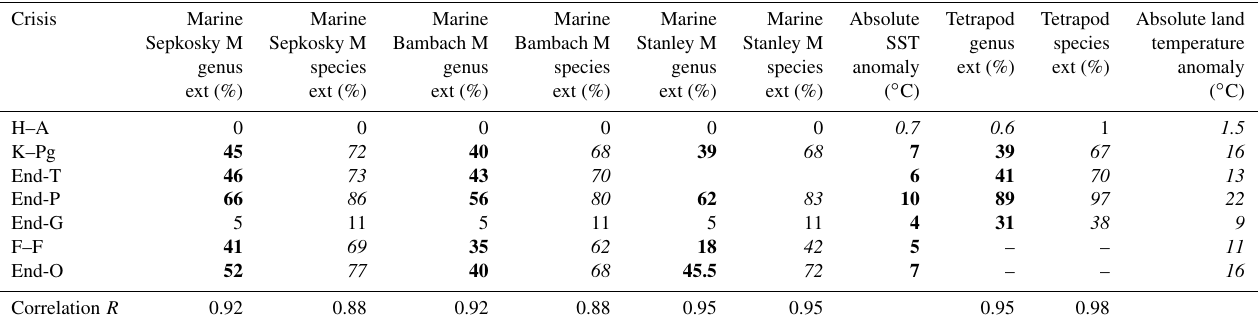
Table 3. Marine and terrestrial genus and species extinction percentages, absolute SST anomaly, land temperature anomaly, and their Pear- son’s correlation coefficient R for Fig.